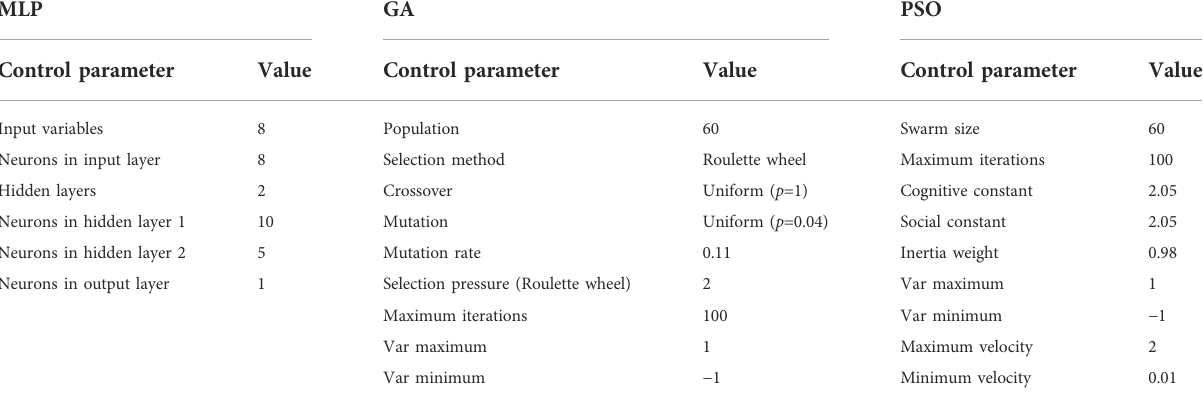
TABLE 2 Control parameters for MLP-GA/ PSO models used for the prediction of fracture density.